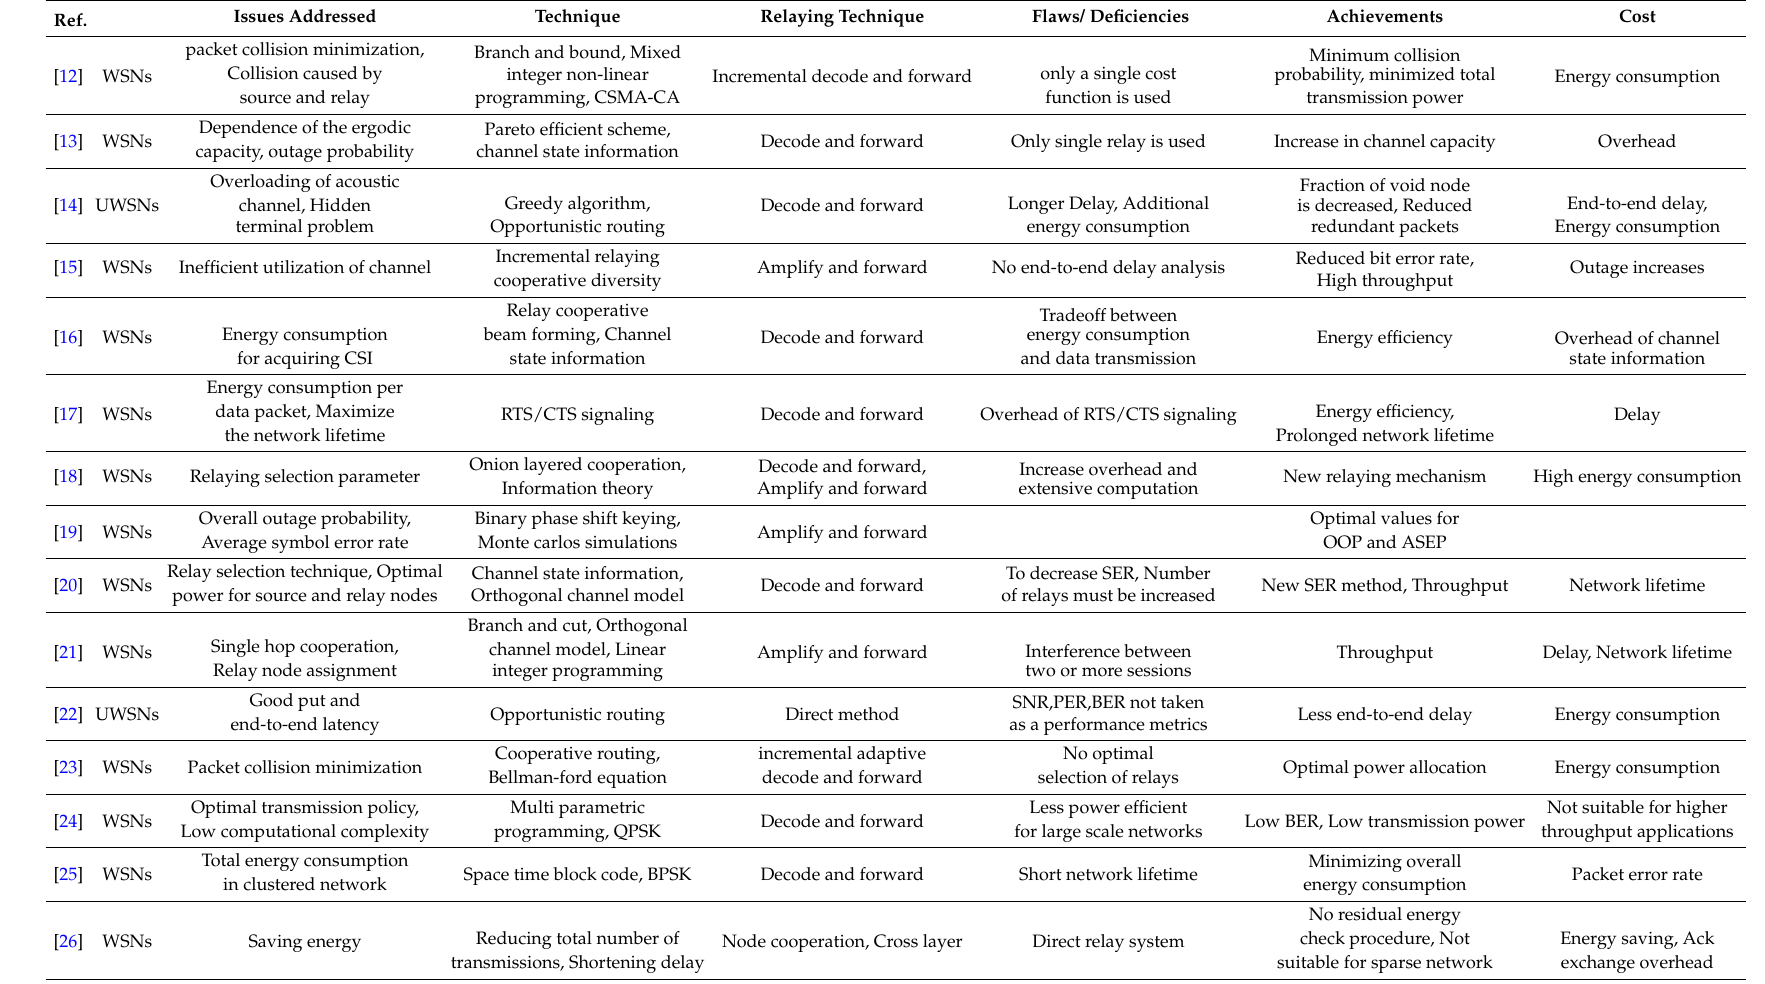
Table 1. Comparison of the Related